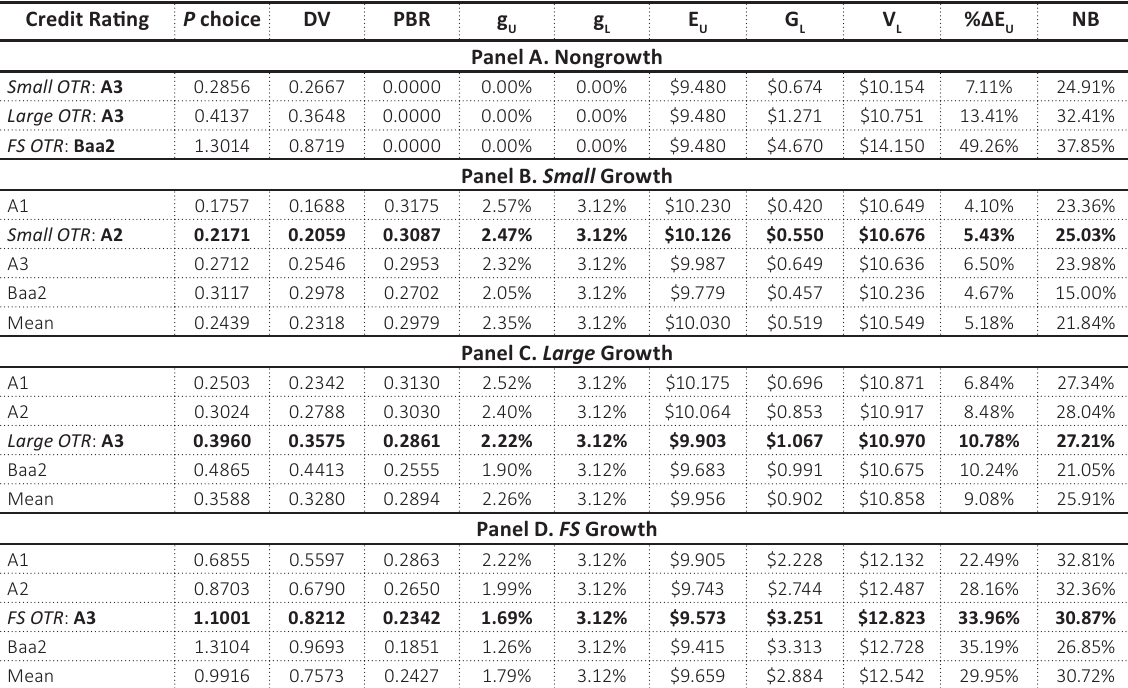
Table 2. Eleven Outcomes for Fifteen C Corp Tests As described in Section 3.3 , this table reports eleven outcomes for fifteen tests. Panel A has the nongrowth results for the three firm categories of small , large , and financial service ( FS) . Only one test is needed to determine a nongrowth OTR , which is reported in the first column. Panels B, C, and D have the growth results for the four medium IG tests for each firm category with the three bold print rows containing the OTRs . The four medium investment grade (IG) ratings of A1, A2, A3, and Baa2 are those used by Damodaran ( 2019